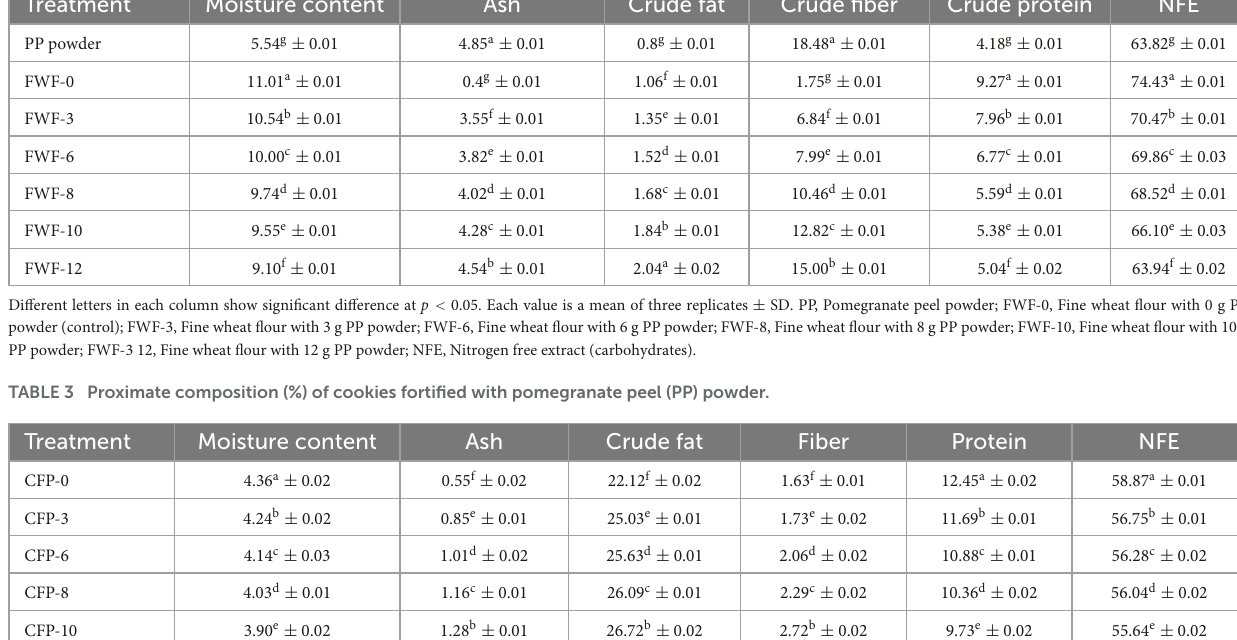
TABLE 2 Proximate analysis (%) of fine wheat flour (FWF) fortified with pomegranate peel (PP) powder. Treatment